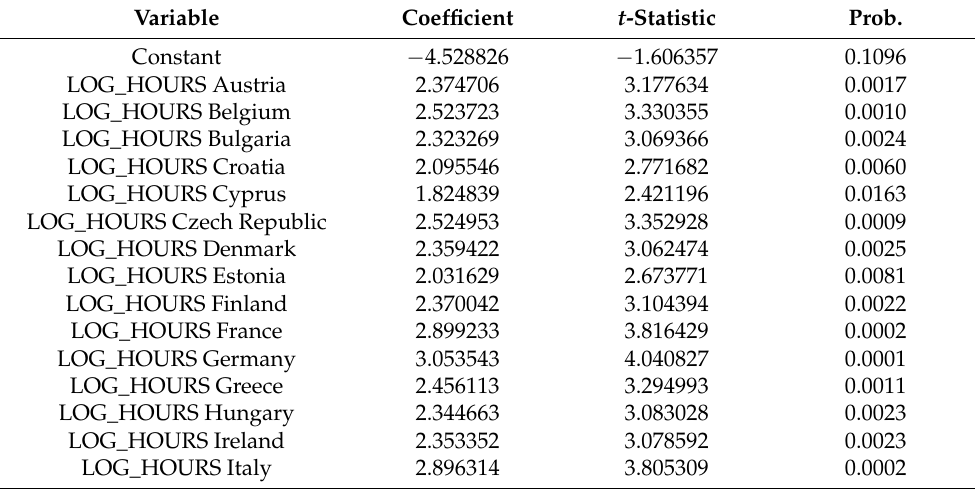
Table 1. Pooled OLS regression to explain the GHG emissions based on worked hours in the EU-28 countries